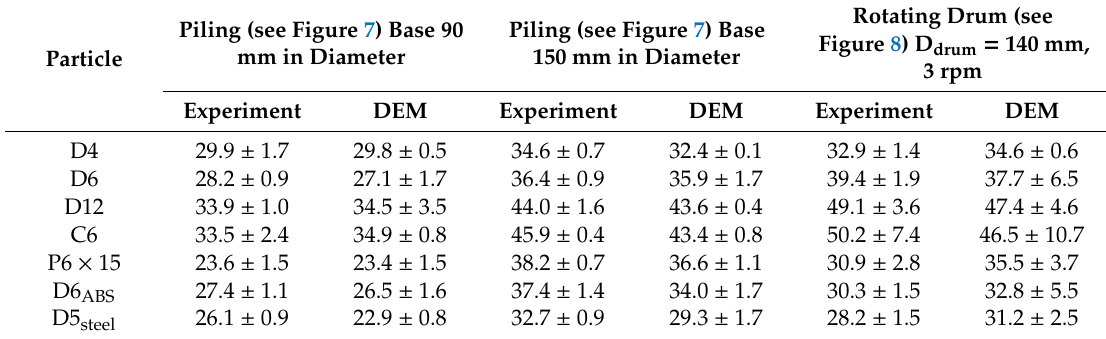
Table 15. Experimental and calibrated AoR values evaluated via geometrical method.